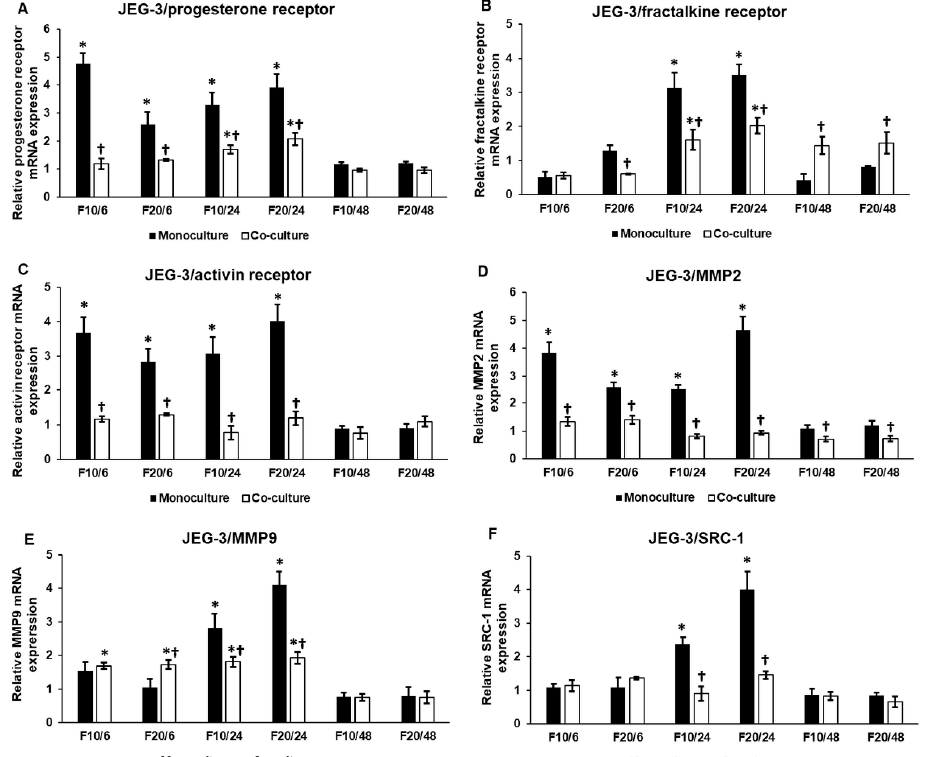
Figure 3. Effects of fractalkine treatments on the mRNA expressions of the implantation-related genes in mono- and co-cultured JEG-3 cells. Real-time PCR was performed with SYBR green protocol using gene specific primers. β -actin was used as house-keeping gene for the normalization. The relative expression of untreated controls was regarded as 1. The mRNA expressions of the treated cells were compared to their appropriate controls (6 h, 24 h or 48 h). ( A ) mRNA expression levels of progesterone receptor. ( B ) mRNA expression levels of fractalkine receptor. ( C ) mRNA expression levels of activin receptor 1B. ( D ) mRNA expression levels of MMP2. ( E ) mRNA expression levels of MMP9. ( F ) mRNA expression levels of SRC-1. The columns represent mean values and error bars represent standard deviation (SD) of three independent determinations ( n = 3). The * indicates p < 0.05 compared to the untreated controls. The † shows p < 0.05 between mono- and co-cultures. Abbreviations of fractalkine treatments: 5 ng/mL-F5; 10 ng/mL-F10; 20 ng/mL-F20.